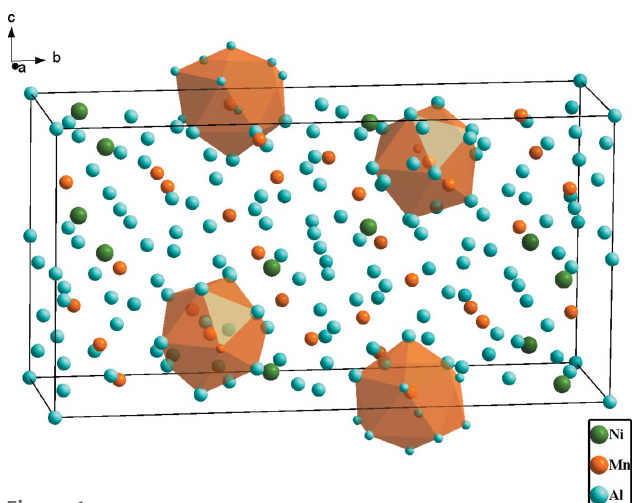
Figure 1 The crystal structure of Al 61.49 Mn 11.35 Ni 4 with two Mn3 atoms and two Mn4 atoms displayed with their coordination environments as